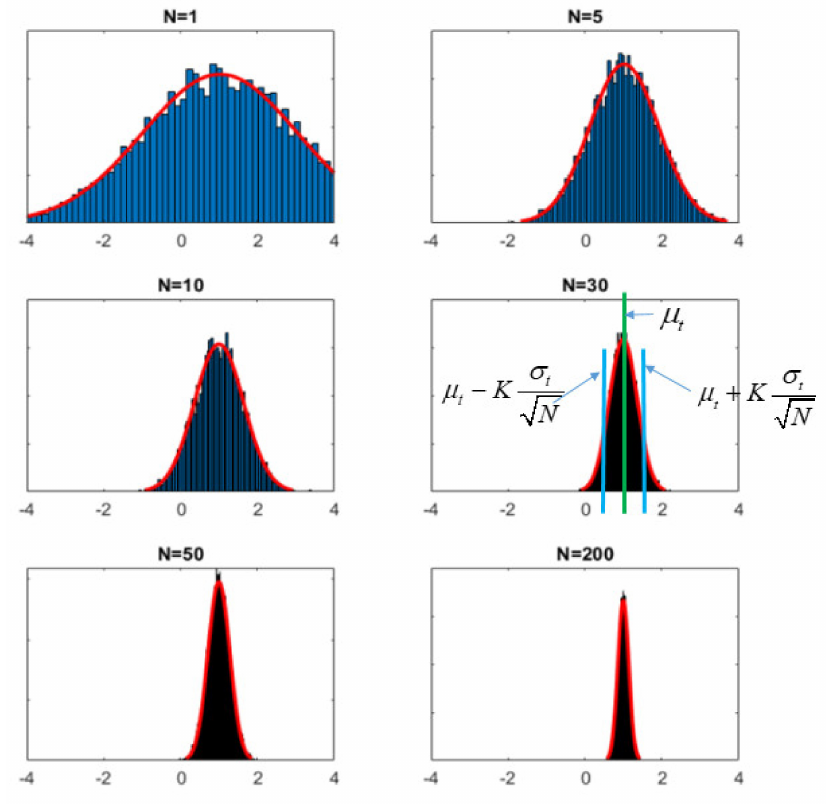
Figure A4. Distribution of the samples' mean with known standard